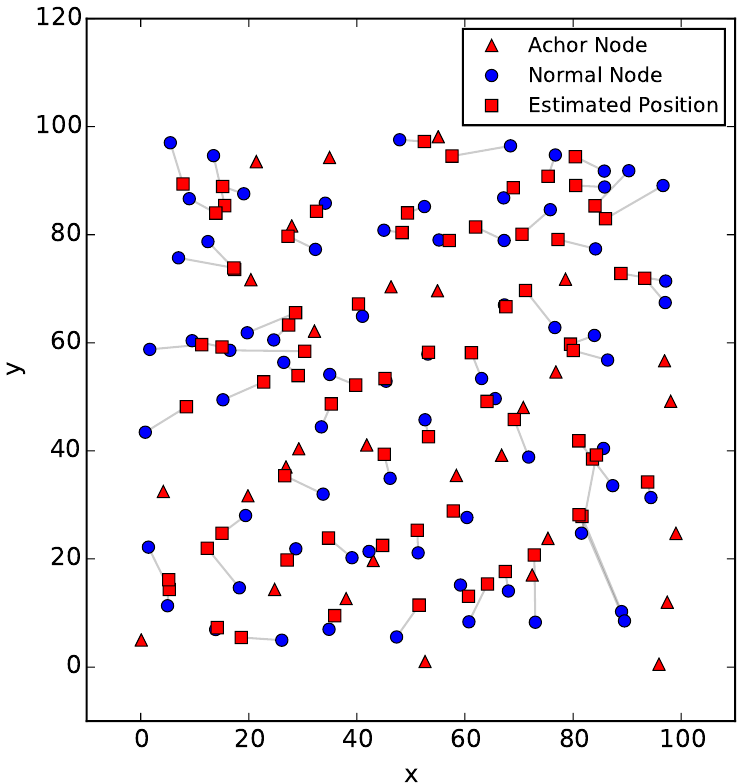
Figure 10. The true and estimated positions of nodes in the WSN.